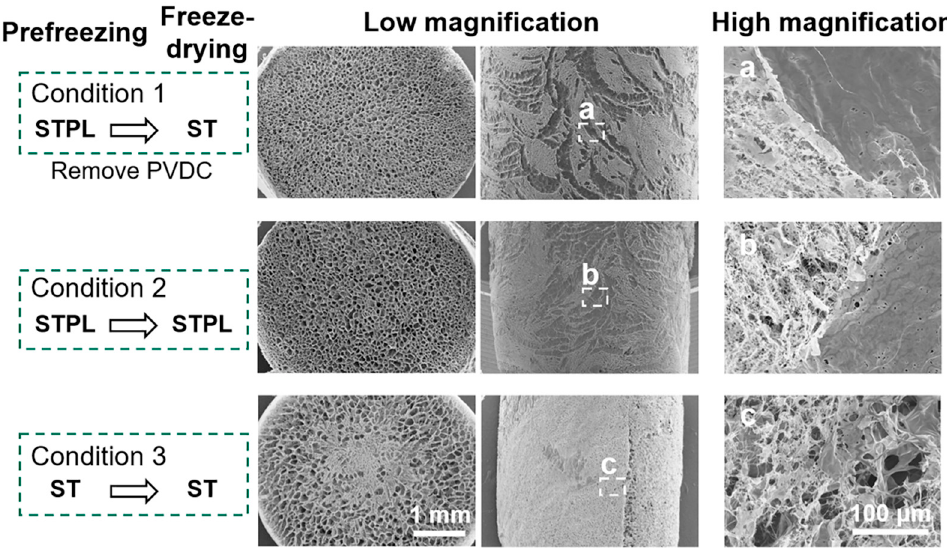
Figure 5. Evaluating the e ff ect of gas permeability on molds during the freezing or drying process. SEM images: cross sections and curved surfaces of gelatin sponges prepared under di ff erent conditions. Condition 1: STPL → ST (prefreezing in the STPL mold, followed by removing PVDC during the freeze-drying process); condition 2: STPL → STPL (prefreezing and freeze-drying in the STPL mold); condition 3: ST → ST (prefreezing and freeze-drying in the ST mold).